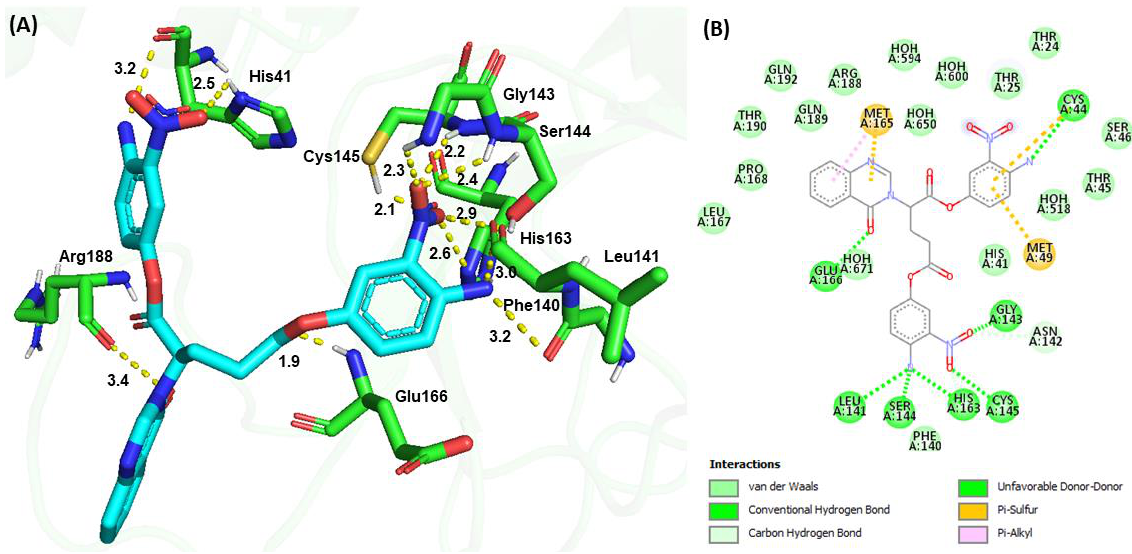
Figure 7. Molecular docking of G4 and SARS-CoV-2 M pro . ( A ) 3D H-bond interactions between G4 (cyan) and M pro (green). ( B ) 2D interactions between G4 and M pro , including H-bond, hydrophobic, π− sulfur, and π−π interactions, as determined by Discovery Studio.